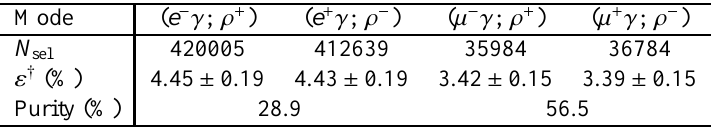
Table 2. Summary of event